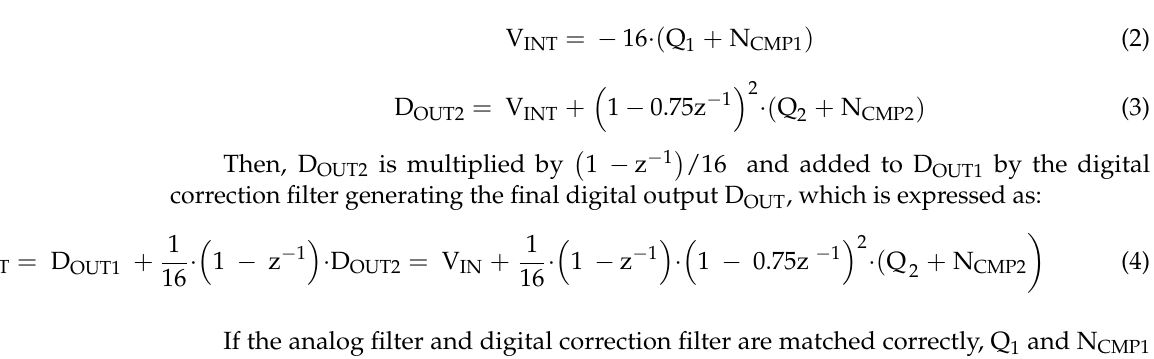
Figure 2. The pipelined noise-shaping SAR ADC block diagram.